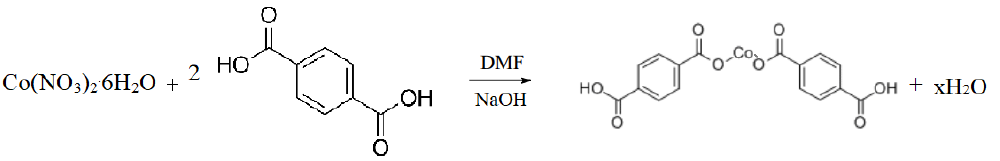
Figure 2. Overall reaction for the synthesis of cobalt terephthalate.